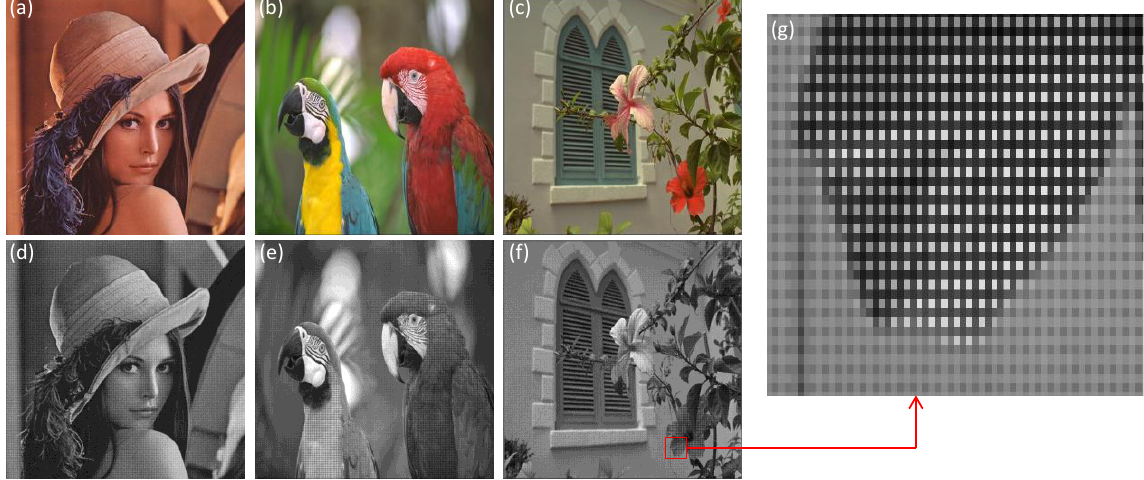
Figure 6. Reference multispectral images and the correspoding down-sampled Bayer images. ( a ) Lena image; ( b ) Parrots image; ( c ) Flowers image; ( d ) Down-sampled Bayer image of Lena; ( e ) Down-sampled Bayer image of Parrots; ( f ) Down-sampled Bayer image of Flowers; ( g ) The enlarged Bayer image for portion of image